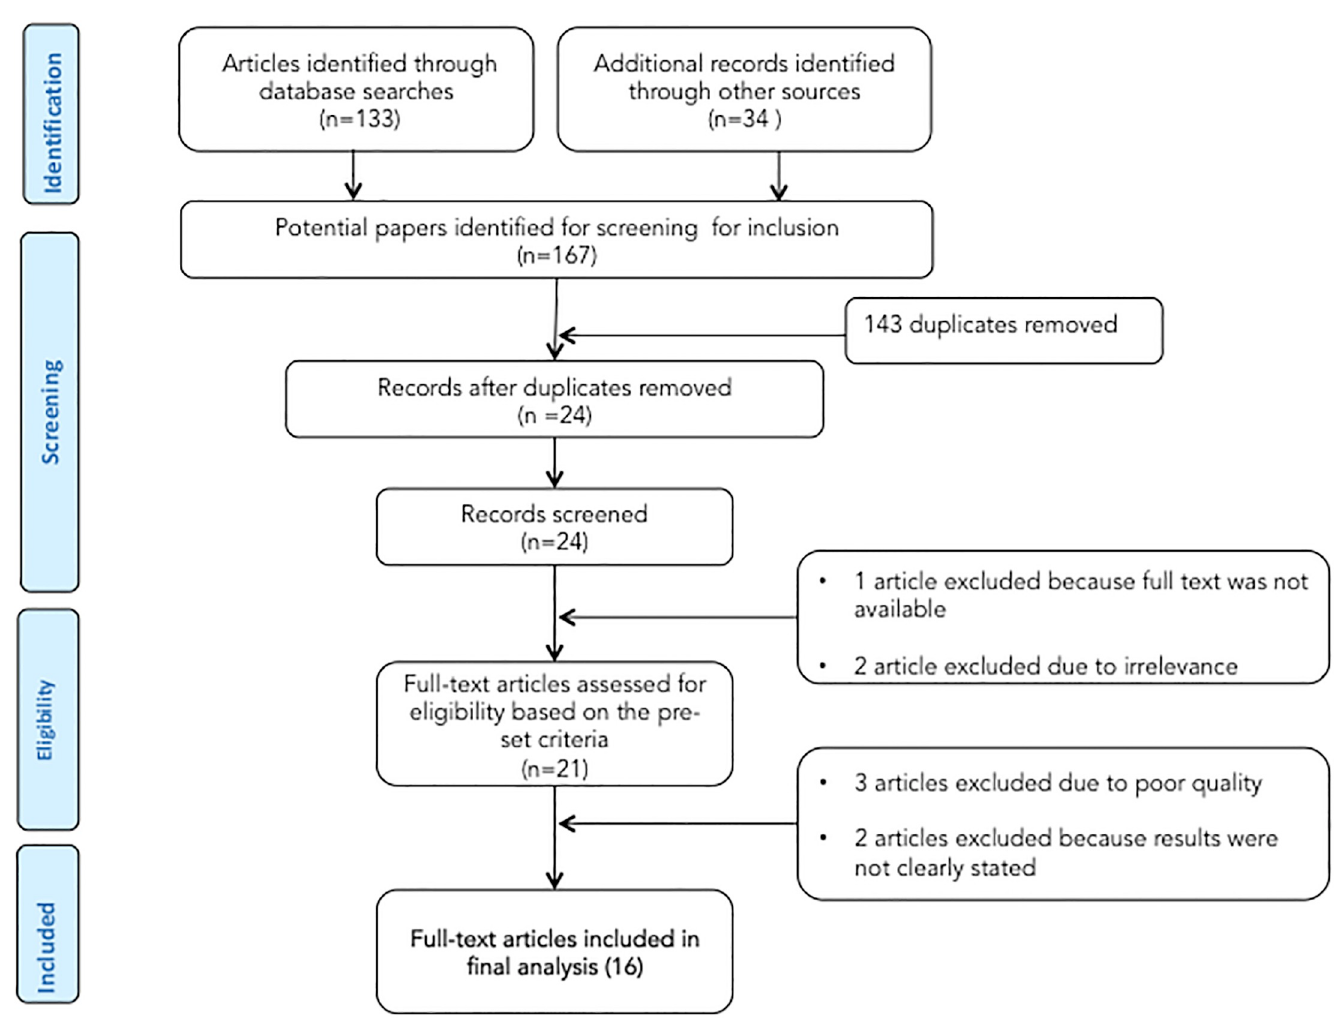
Fig 1. Flow diagram for selection of